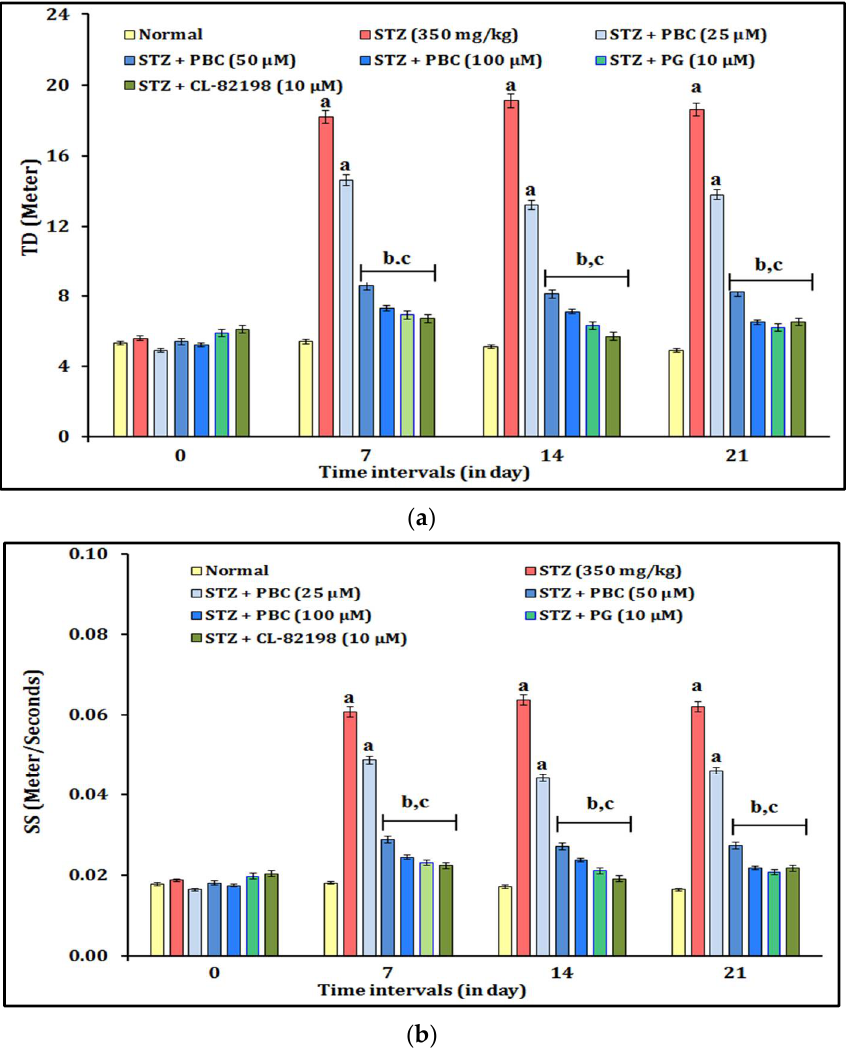
Figure 1. ( a ) Effect of PBC in DNP-induced TD changes in thermal pain sensation. Data are expressed as mean ± SD, n = 20 zebrafish per group. Abbreviation: CL-82198, MMP-13 inhibitor; PG, pregabalin; STZ, streptozotocin; TD, travel distance. ( b ) Effect of PBC in DNP-induced SS changes in thermal pain sensation. Data are expressed as mean ± SD, n = 20 zebrafish per group. Abbreviation: CL-82198, MMP-13 inhibitor; PG, pregabalin; SS, swimming speed; STZ, streptozotocin. a p < 0.05 vs. normal group. b p < 0.05 vs. STZ control group. c p < 0.05 vs. PBC (25 µ M)